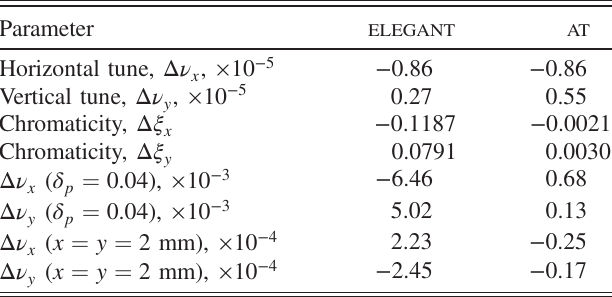
TABLE V. Changes of lattice parameters when the APS-U straight dipoles are replaced by sector dipoles, calculated with ELEGANT and AT .